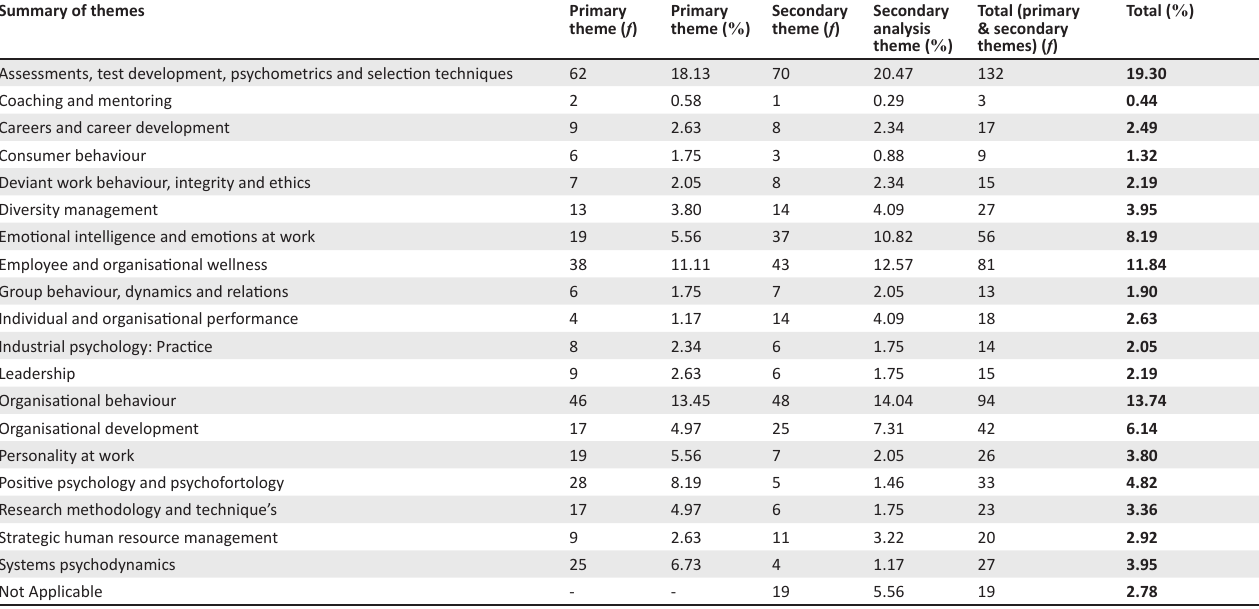
TABLE 5: Frequencies and percentages of primary and secondary content themes in Industrial and Organisational Psychology research-practice (2004–2013). Summary of